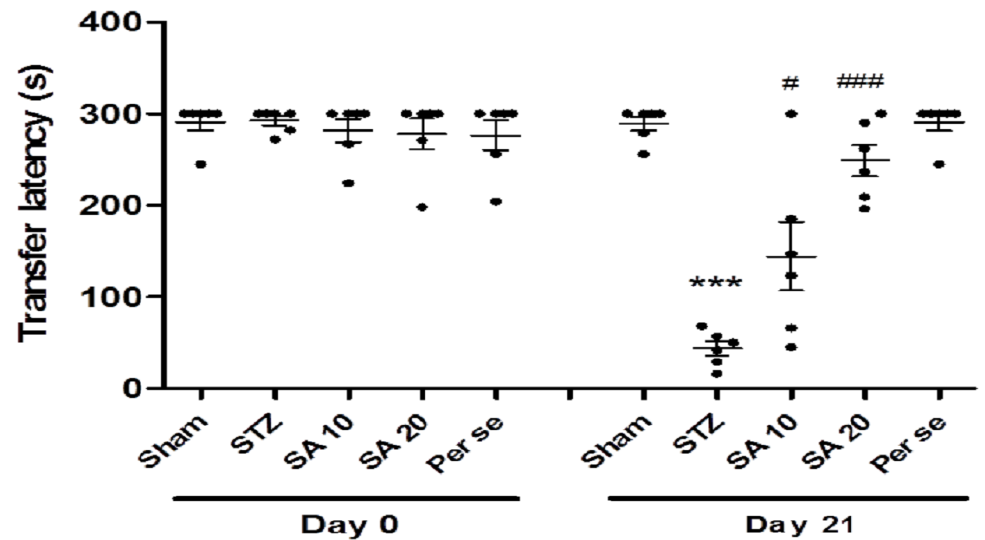
Figure 4. E ff ect of di ff erent doses of sinapic acid on retention latency in passive avoidance. Data are presented as mean ± SEM, ( n = 6), * as compared to the sham group, # as compared to the STZ group. *** p < 0.001, # p < 0.05, ### p < 0.001. STZ—Streptozotocin, SA—Sinapic acid.